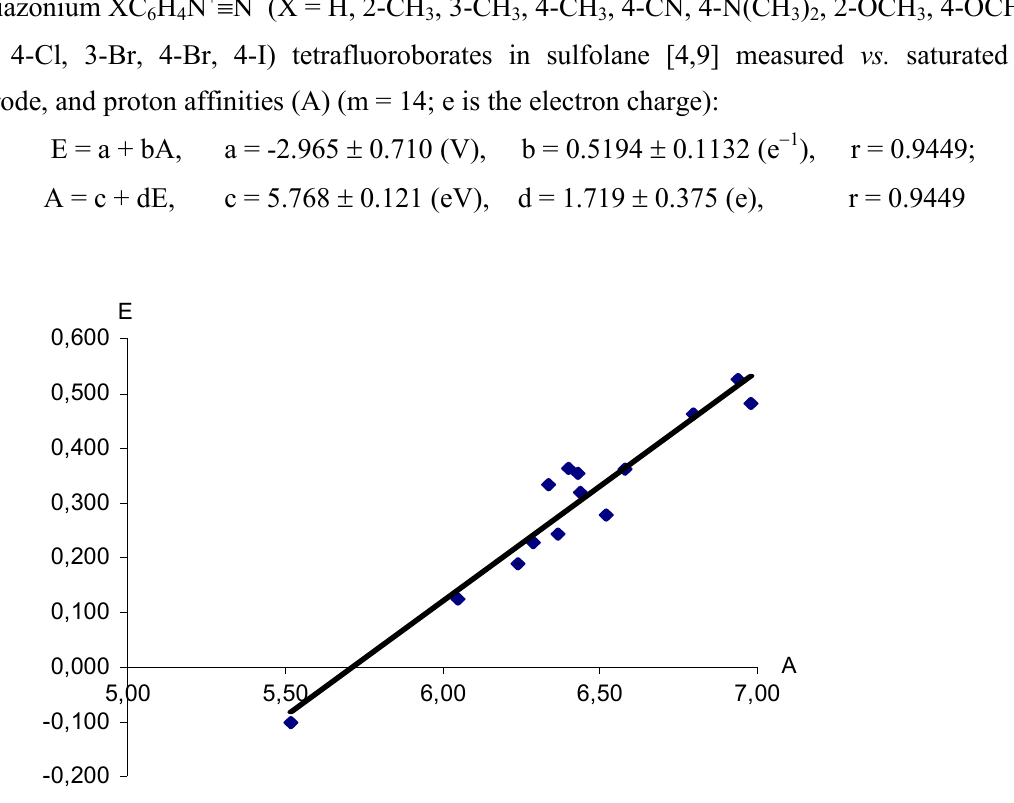
Cl electrode) upon computed proton 2 2 , 4-CH , 4-N(CH ) , 3-NO , 4-NO , 4-OCH , 3-F, 4-F, 4-SO 3 3 3 2 2 2 3